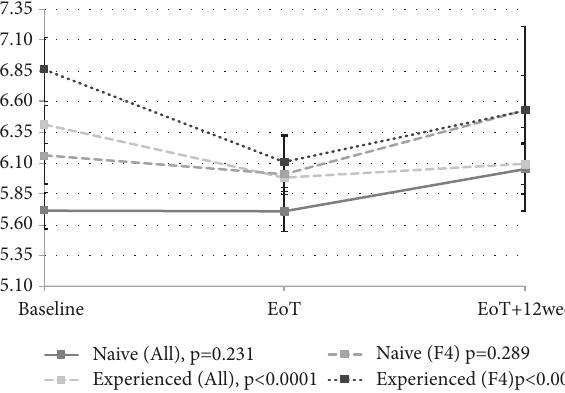
Figure 3: Changes of fasting glycemia with treatment in naive and experienced patients in the whole group and separately for F4 fibrosis patients. EoT: end of treatment; EoT+12w: 12 weeks after the end of treatment.